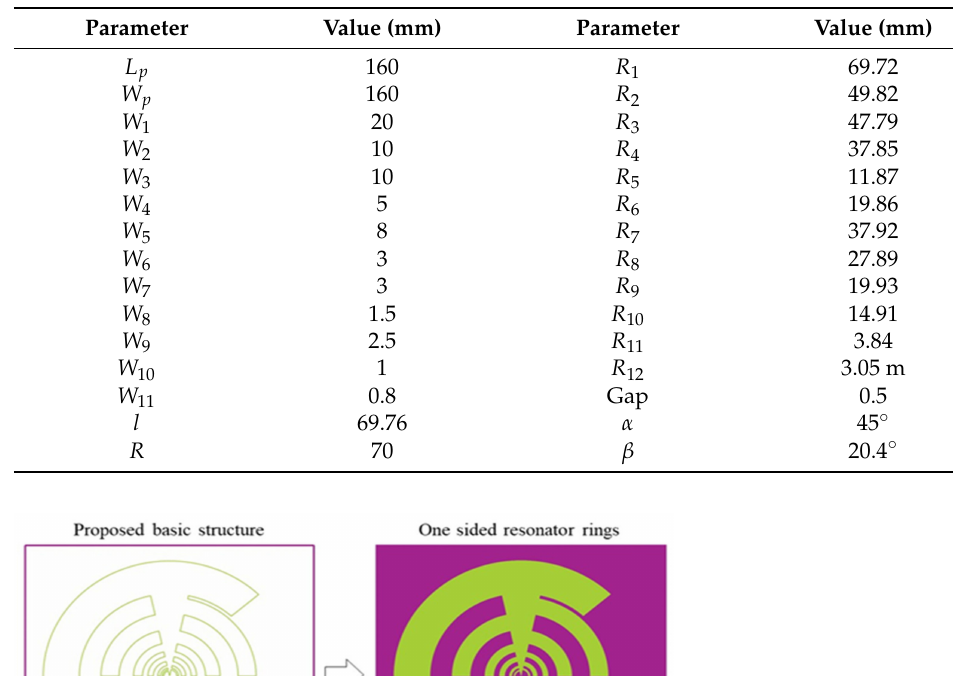
Table 2. Log-periodic antenna design parameters.